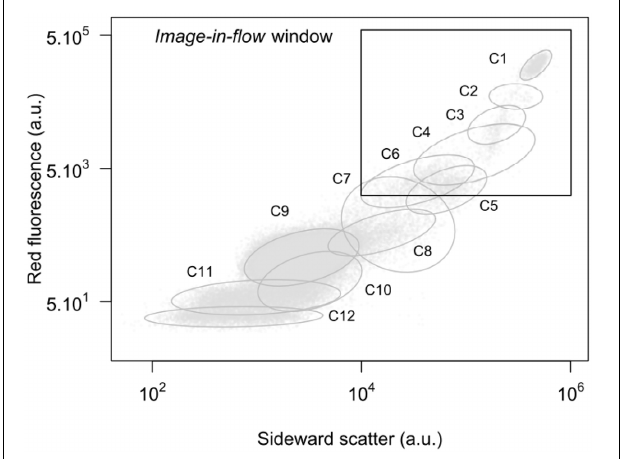
FIGURE 4 | Exponential relationship between total sideward scatter and biovolume of the cells pictured by the “image-in-flow” camera ( n = 693) mounted on the Cytosense.